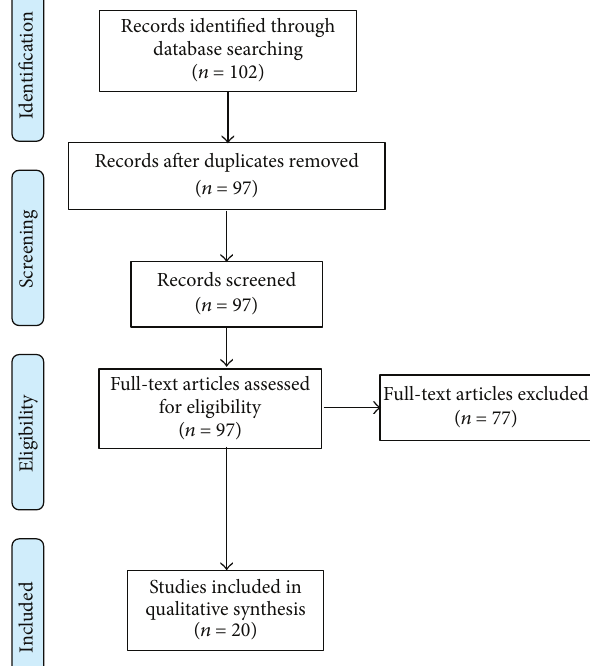
Figure 1: PRISMA diagram illustrating systematic searches for this